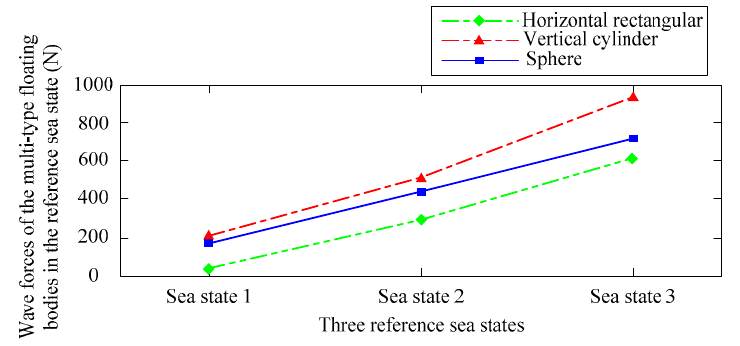
Figure 7. The capture width ratio of the multi-type floating bodies ( H = 0.3 m, T = 3.5 s).